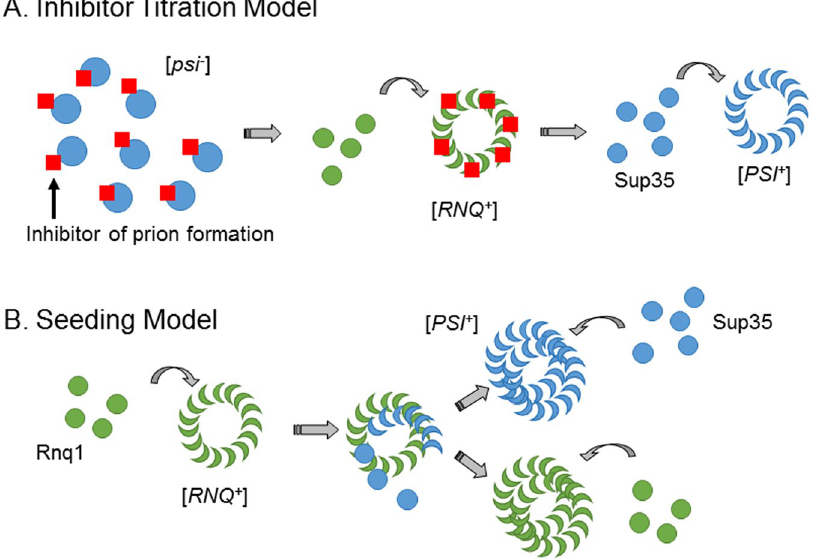
Figure 1. Models for the [ RNQ + ]-dependent formation of the [ PSI + ] prion. ( A ) The inhibitor titration model suggests that an inhibitor molecule (red squares) binds to Sup35 in its soluble state (blue circles). The presence of [ RNQ + ] (green ring) sequesters the inhibitor away from Sup35, thereby allowing the protein to aggregate and form [ PSI + ]. ( B ) The seeding model suggests that there is a physical interaction between Sup35 and aggregated Rnq1 during the formation of [ PSI + ]. After the interaction, the [ RNQ + ] and [ PSI + ] prions are propagated